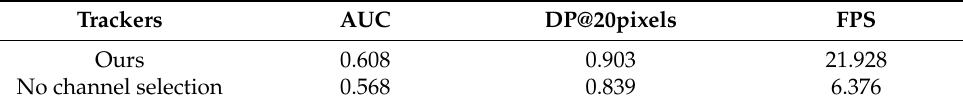
Table 3. Tracking performance comparison with and no channel selection.